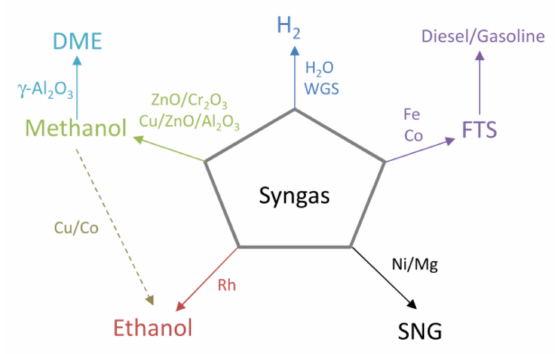
Figure 6. Syngas conversion routes to second-generation biofuels (adapted from Spath and Dayton